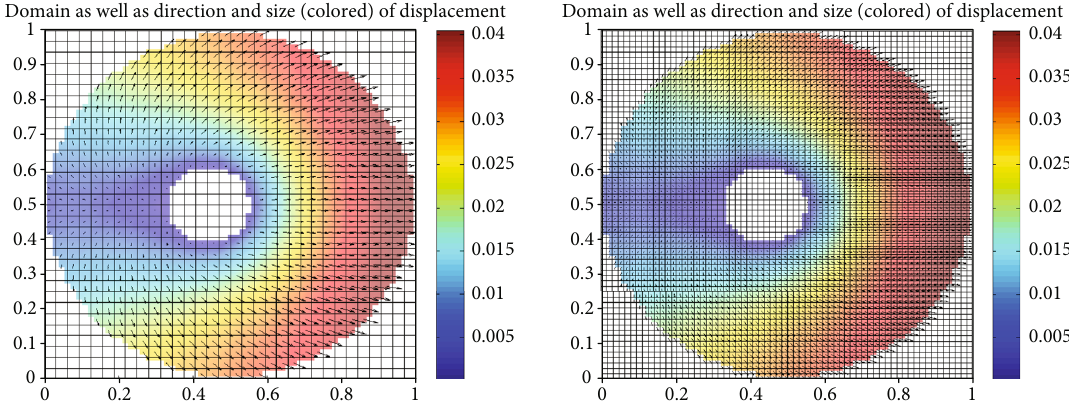
Figure 6: Numerical solution for H = 32, 64 .